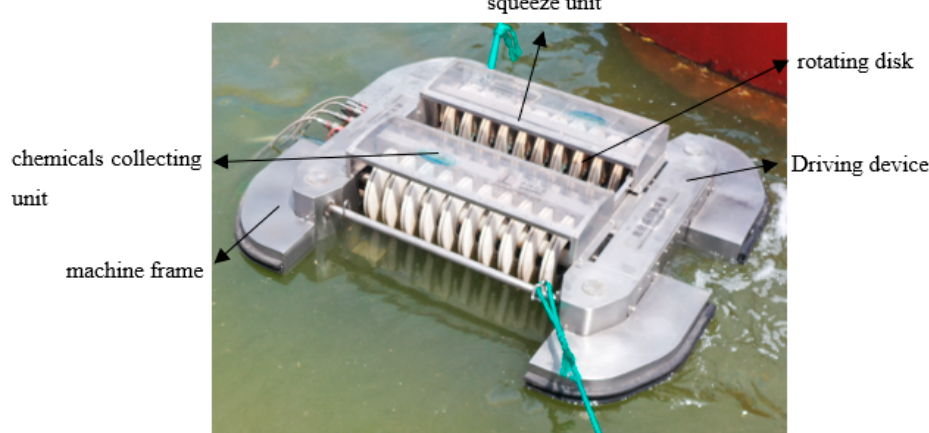
Figure 2. Image of the chemical collector